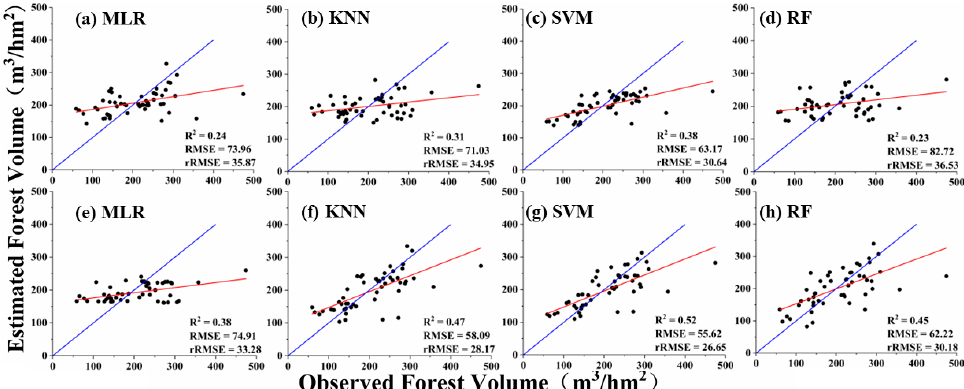
Figure 6. Scatter plots between measured and predicted GSV with different feature selection meth- ods and models using GF-1 images; ( a – d ) show the results using Pearson correlation and ( e – h ) show the results using the proposed method.